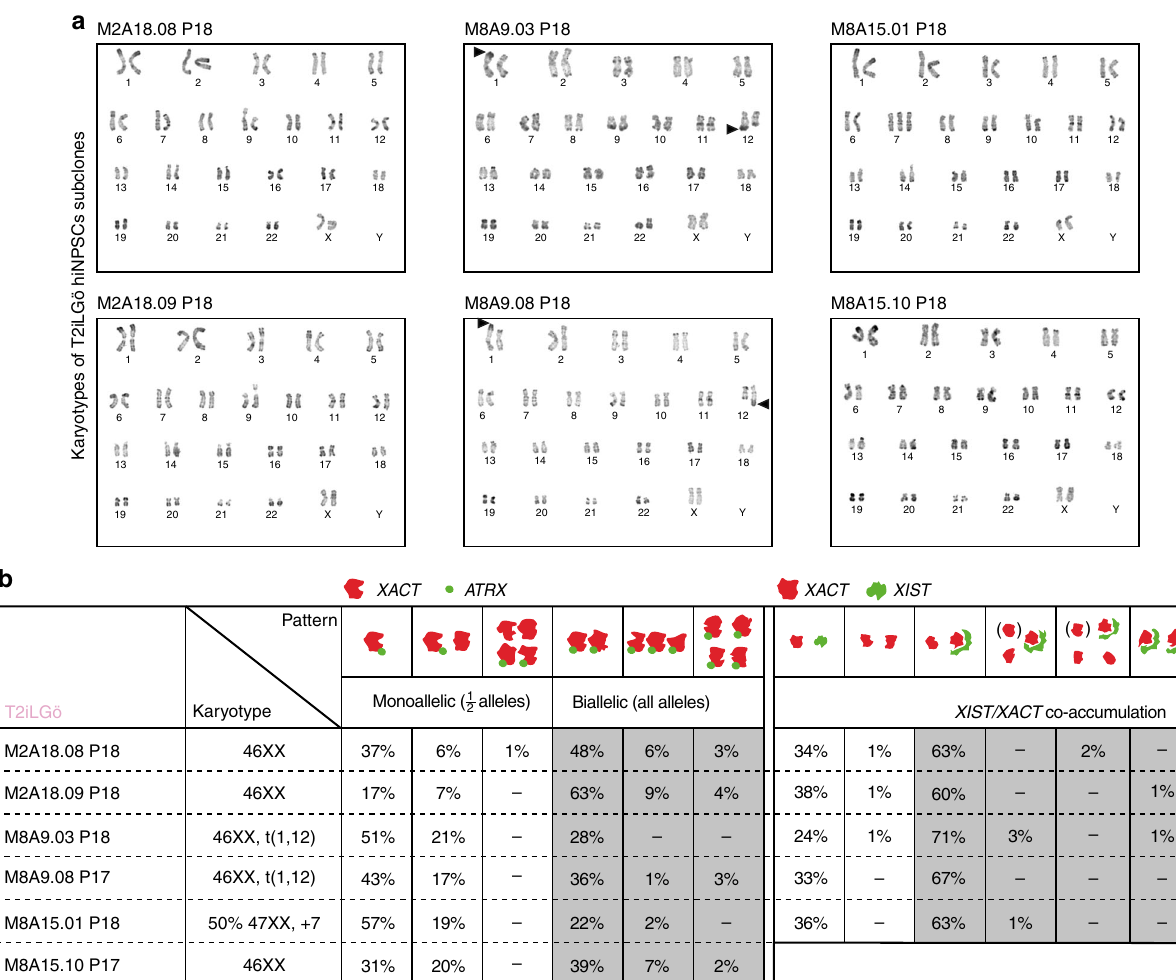
Karyotype analysis . Karyotyping based on RTG-banding was performed at Cytogenetic Laboratory (CHU Nantes) using standard methods with minor modi fi cations. Brie fl y, hiPSCs and hiNPSCs were plated on Lab-Tek chamber slide. At 70% con fl uence, PSCs were submitted to hypotonic shock (20% fetal bovine serum in water), fi xed in methanol/glacial acetic acid 3:1, then stained in Giemsa stain. Metaphase spreads for each sample were analyzed. A total of 30 pictures per slides were automatically acquired, chromosomes counted and at least 10 kar- yotypes for each cell line were classi fi ed. The commercial L8 fi broblast line contains a translocation from the chromosome 10 to 7 that is found in all derived iPSC lines. The B1 and M3 fi broblasts had normal karyotypes. Immuno fl uorescence . For IF analysis, cells and embryos were fi xed at room temperature using 4% paraformaldehyde for 15min and 30min (on a rotating shaker for embryos), respectively. Samples were then permeabilized and blocked in IF buffer (IF buffer: phosphate-buffered saline (PBS) – 0.2% Triton, 10% fetal bovine serum) for 60 min at room temperature. Samples were incubated with primary antibodies overnight at 4 °C. Incubation with secondary antibodies was performed for 2h at room temperature along with 4 ′ ,6-diamidino-2-phenylindole (DAPI) counterstaining. Primary and secondary antibodies with dilutions used in this study are listed in Supplementary Table 2. Imaging fl ow cytometry . Cells were stained with the Zombie NIR TM viability kit (BioLegend cat. no. 423105) for 20 min on ice. Potential nonspeci fi c binding sites were blocked by incubation with human serum (obtained from healthy donor at the French blood establishment EFS) diluted to 1:20 in PBS for 30 min. Before performing intracellular staining, cells were fi xed and permeabilized for 30 min on ice, using the Fixation/Permeabilization concentrate (eBioscience cat. no. 00-5123)